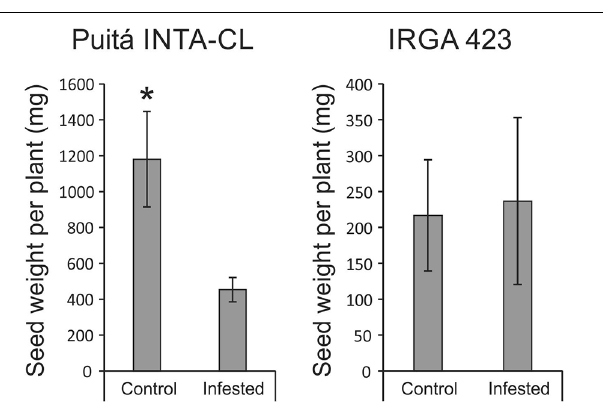
FIGURE 5 | Seed weight per plant (estimative of yield) of the two tested cultivars (Puitá INTA-CL and IRGA 423). Represented values are the averages of 10 samples ± SE. Mean values with one asterisk are significantly different as determined by the Student’s t -test ( P ≤ 0.05).